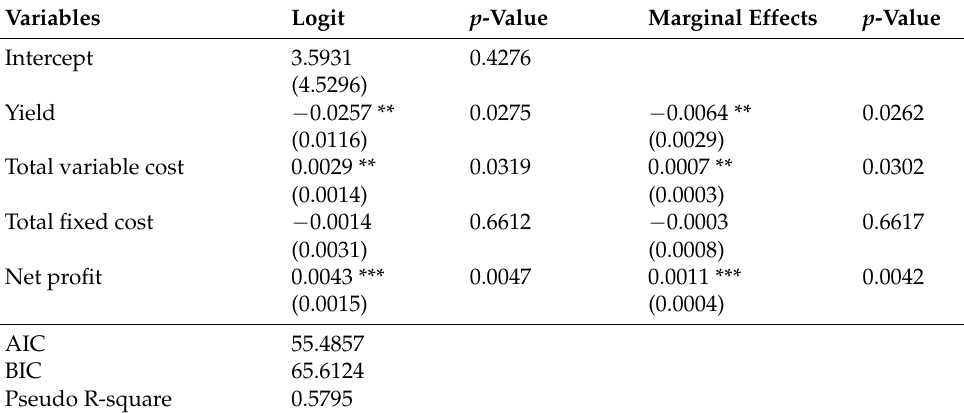
Table 5. Estimates of the effect of cost and return on AWD adoption